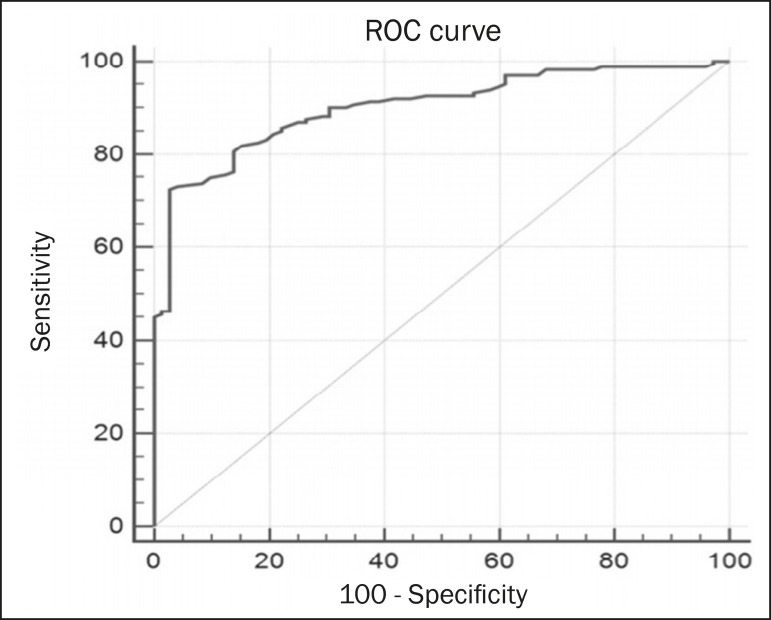
ROC curve to evaluate the diagnostic accuracy of the ADC value in the
diagnosis of breast lesions.